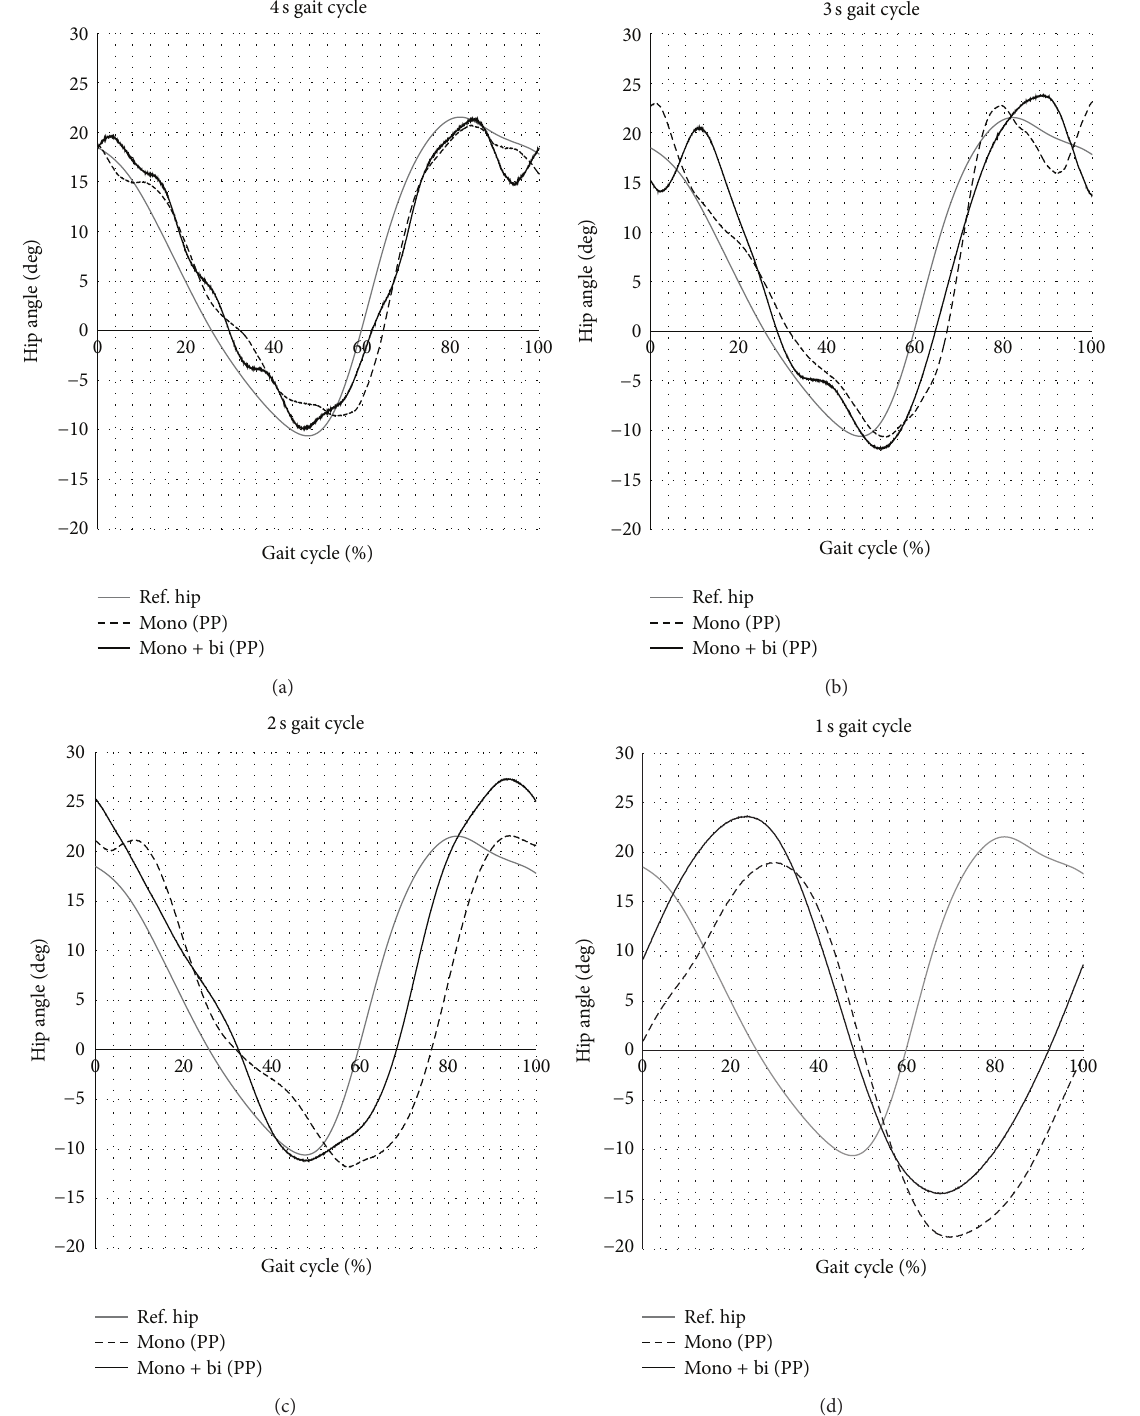
Figure 9: Hip joint trajectory for the control of the leg orthosis WO/S using a cocontraction model based PP controller.